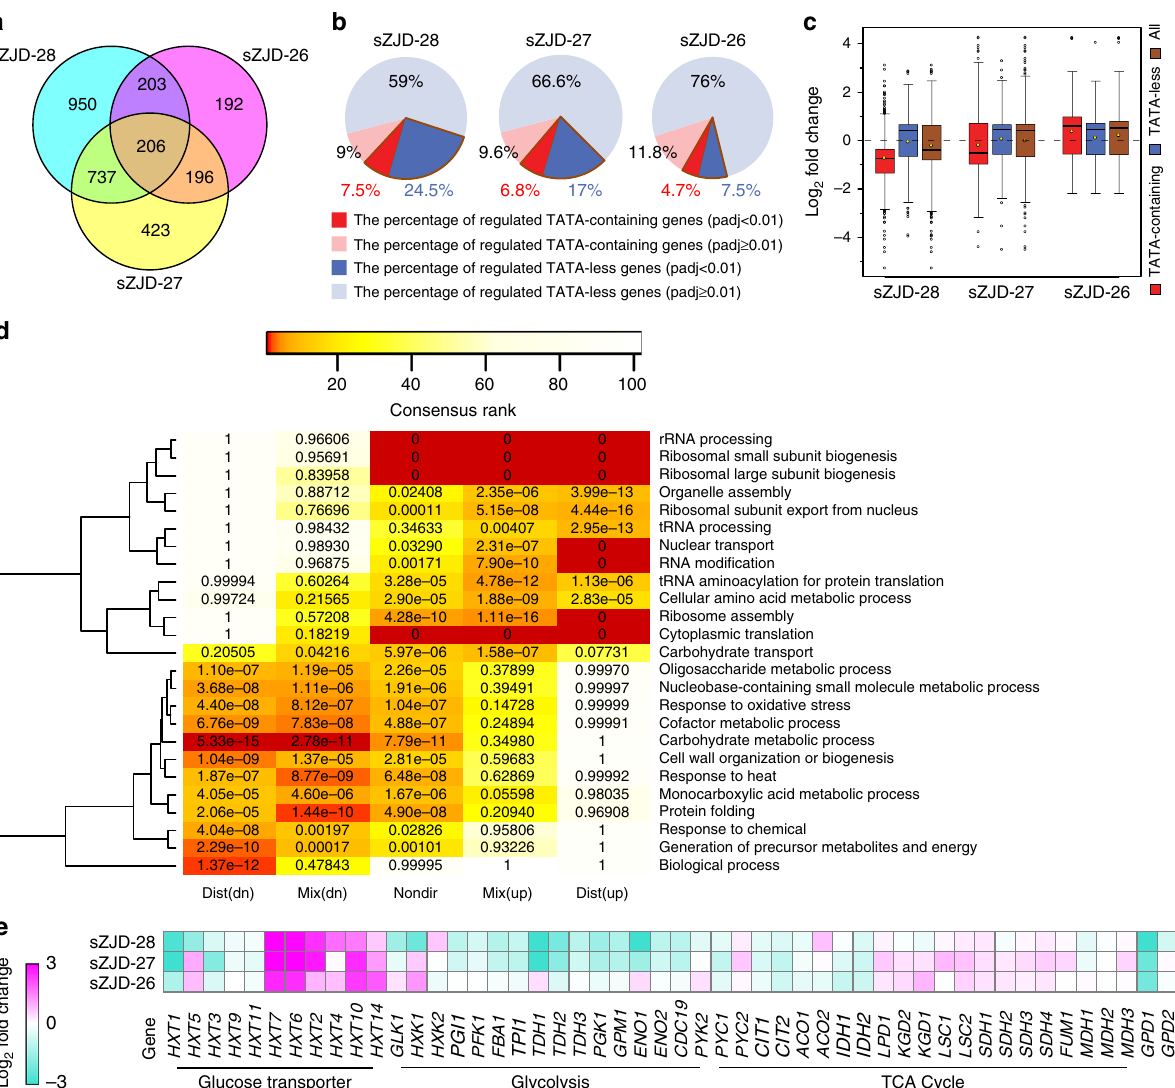
Fig. 3 Transcriptional analysis of reverse engineered strains and parental strain. a Venn diagram showing the numbers of signi fi cantly (padj < 0.01) regulated genes of reverse engineered strains compared with the parental strain. b Fraction of TATA-containing and TATA-less genes among differentially regulated genes in sZJD-28, sZJD-27, and sZJD-26. c Box plot of the log 2 -fold change of the signi fi cantly (padj < 0.01) regulated genes in sZJD-28, sZJD- 27, and sZJD-26. The bold line in the box represents the median and the yellow dot represents the mean. The lower and upper bounds of the box indicate the fi rst and third quartiles, respectively, and whishers represent ±1.5× the interquartile range (IQR). d Reporter GO term analysis of the transcription pro fi les of sZJD-28. The color key shows the rank of the GO terms, and the signi fi cance ( p value) of the GO terms is included in each cell of the heatmap. GO terms that have a consensus rank ≤ 10 in any of the groups are shown in the heatmap. Dist (dn) is distinct-directional down, Mix (dn) is mixed- directional down, Nondir is non-directional change, Mix (up) is mix-directional up, and Dist (up) is distinct-directional up. e Transcriptional levels of genes related to glucose transportation, glycolysis pathway, and TCA cycle in sZJD-28, sZJD-27 and sZJD-26 compared with sZJD-25